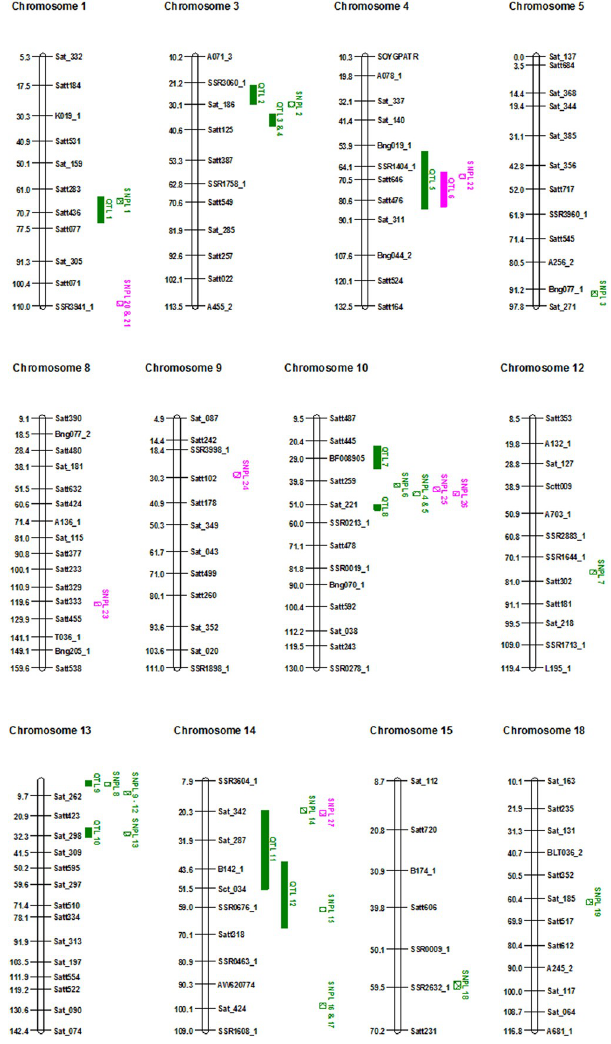
Fig 6. The genetic map of the F . virguliforme foliar SDS and root rot resistance SNPL. Green checked box, foliar SDS SNPL; Pink checked box, root rot SNPL. SNPL are shown with numerical numbers (Tables 1 and 2). Previously identified foliar SDS and root rot resistance QTL are shown with solid green and pink boxes, respectively (S2 Table). The genetic map is generated in centi-Morgan (cM) unit.